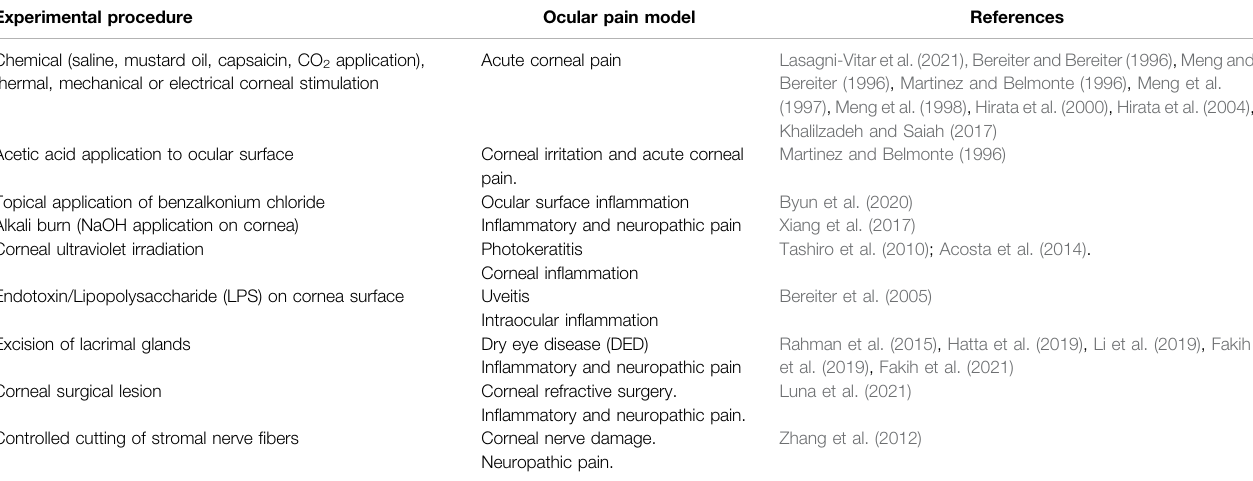
TABLE 1 | Summary of experimental approaches used to induce and study ocular pain in